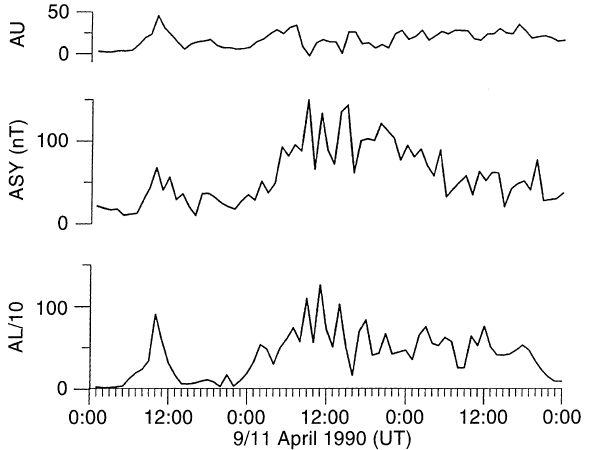
Fig. 13. Comparison between the electrojet indices (AL and AU) and ASY on 9–11 April 1990